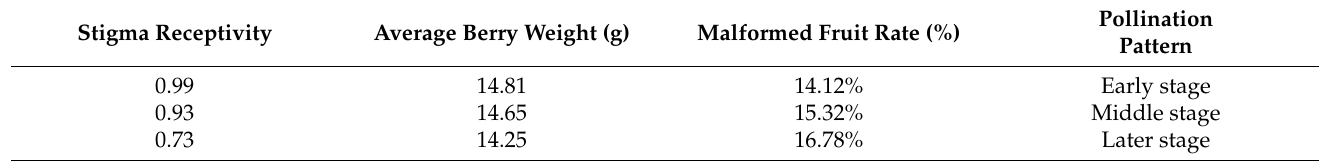
Table 5. Impacts of stigma receptivity in artificial pollination